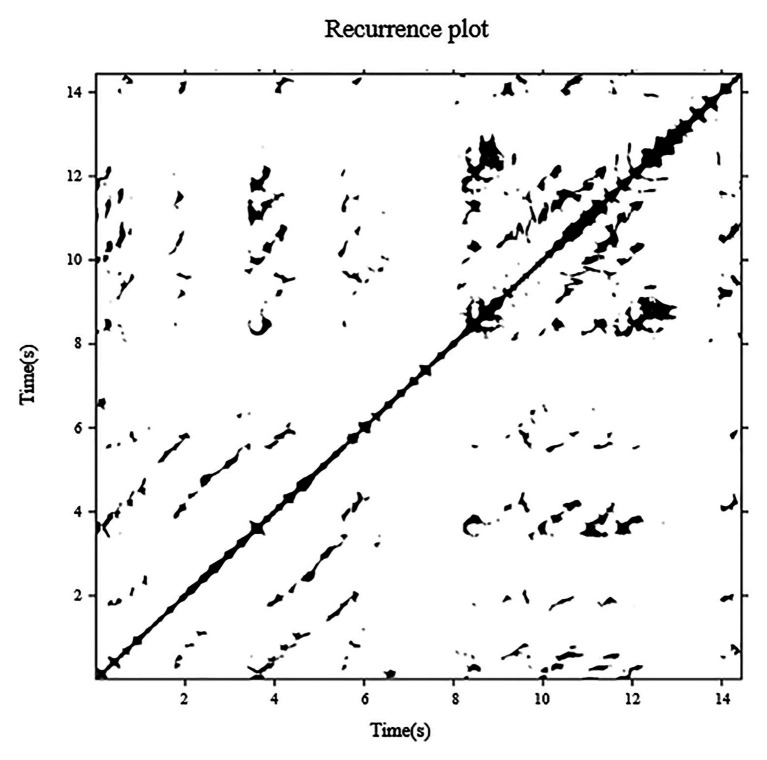
Recurrence plot of a COP signal in the AP direction from a 4-year-old child under the condition of ECHB duration 15 s (time delay = 28 samples, embedded dimension = 3, and recurrence rate = 5%).